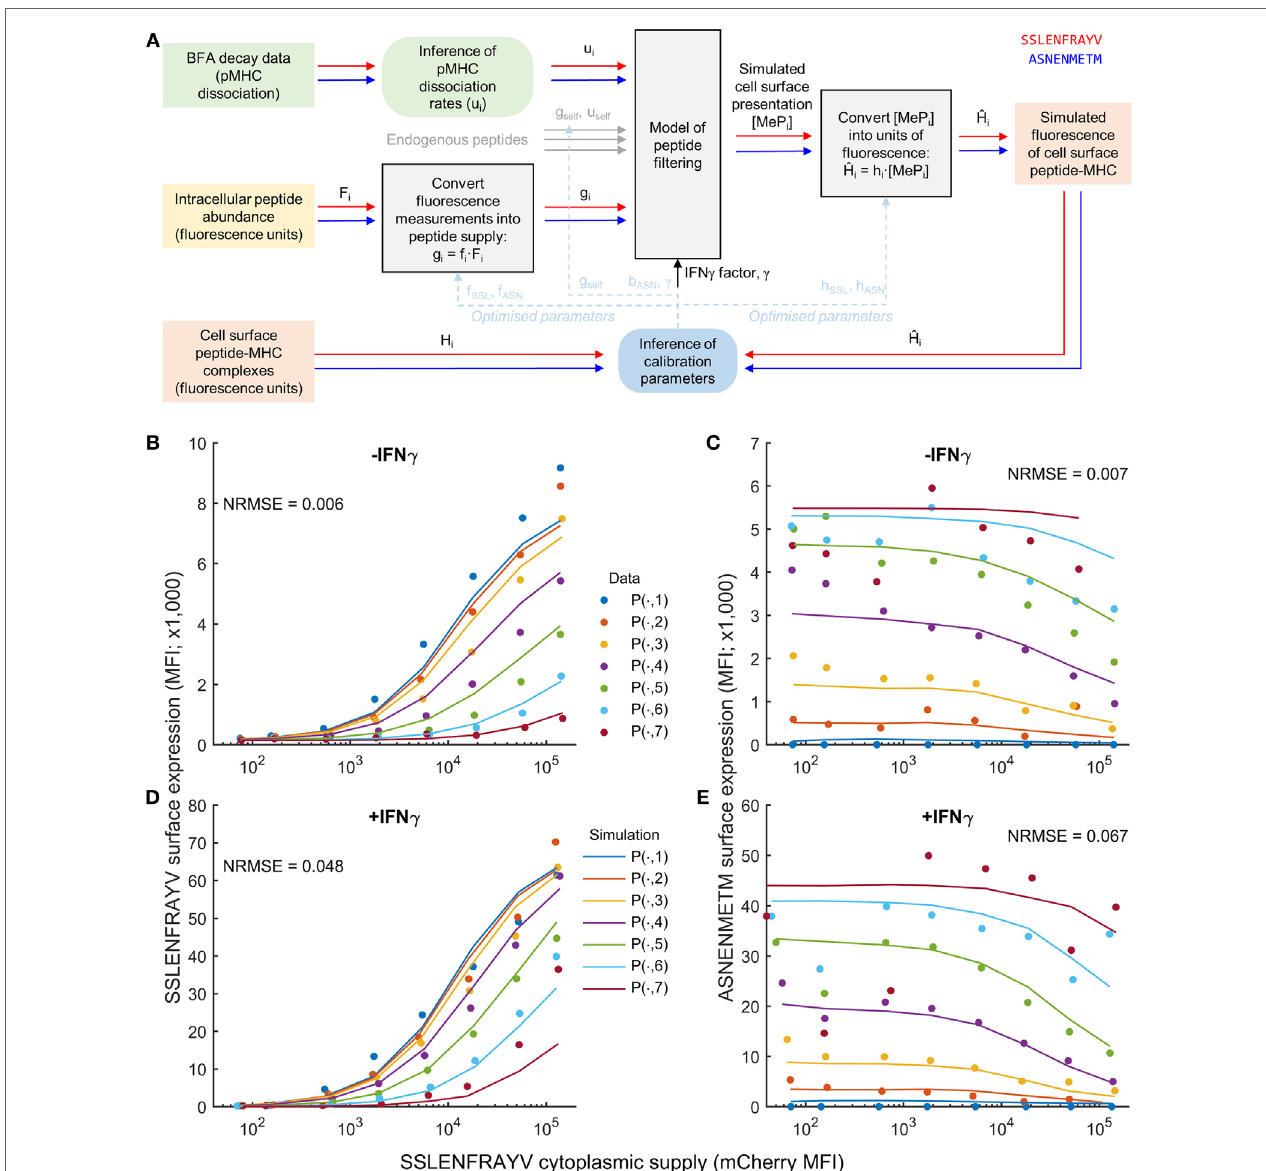
FigUre 2 | Calibration of a mechanistic model of peptide competition. (a) Diagrammatic representation of the process of model calibration. The cytoplasmic concentration of each peptide and their MHC unbinding rate were used as inputs to the model, which was then fit to fluorescence data of the pMHC complex surface abundance. Square colored boxes indicate measured or simulation data, gray boxes indicate models, and rounded boxes represent inference algorithms. The red and blue line connectors represent peptide-specific information, and the dashed blue lines indicate that inferred parameters are eventually substituted back into the models for simulation/prediction. (b–e) Comparison of the model (solid lines) evaluated at the maximum likelihood parameter values against experimental measurements (circles) for a single experiment measuring SSLENFRAYV/ASNENMETM competition. The different colors represent different cytoplasmic levels of ASNENMETM, as shown in Figure 1 . The normalized root mean square error (NRMSE) between the data and the simulation is also indicated for each comparison. An equivalent comparison for a second experiment that was also included in the parameter calibration is shown in Figure S6 in Supplementary